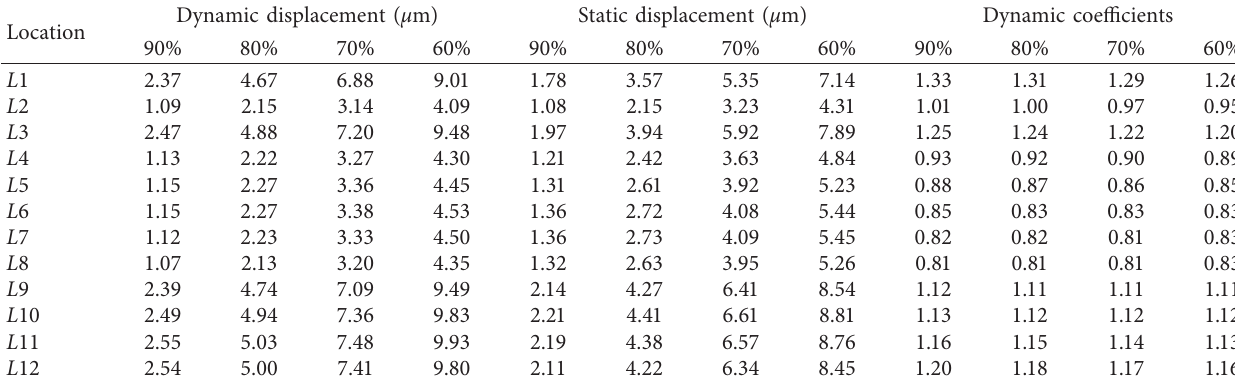
Table 14: Dynamic coefficients of points under each vibration-isolation efficiency.